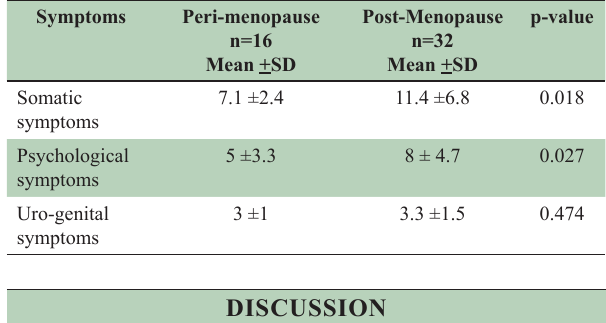
Table-V: Comparison of symptoms in peri-Menopause and